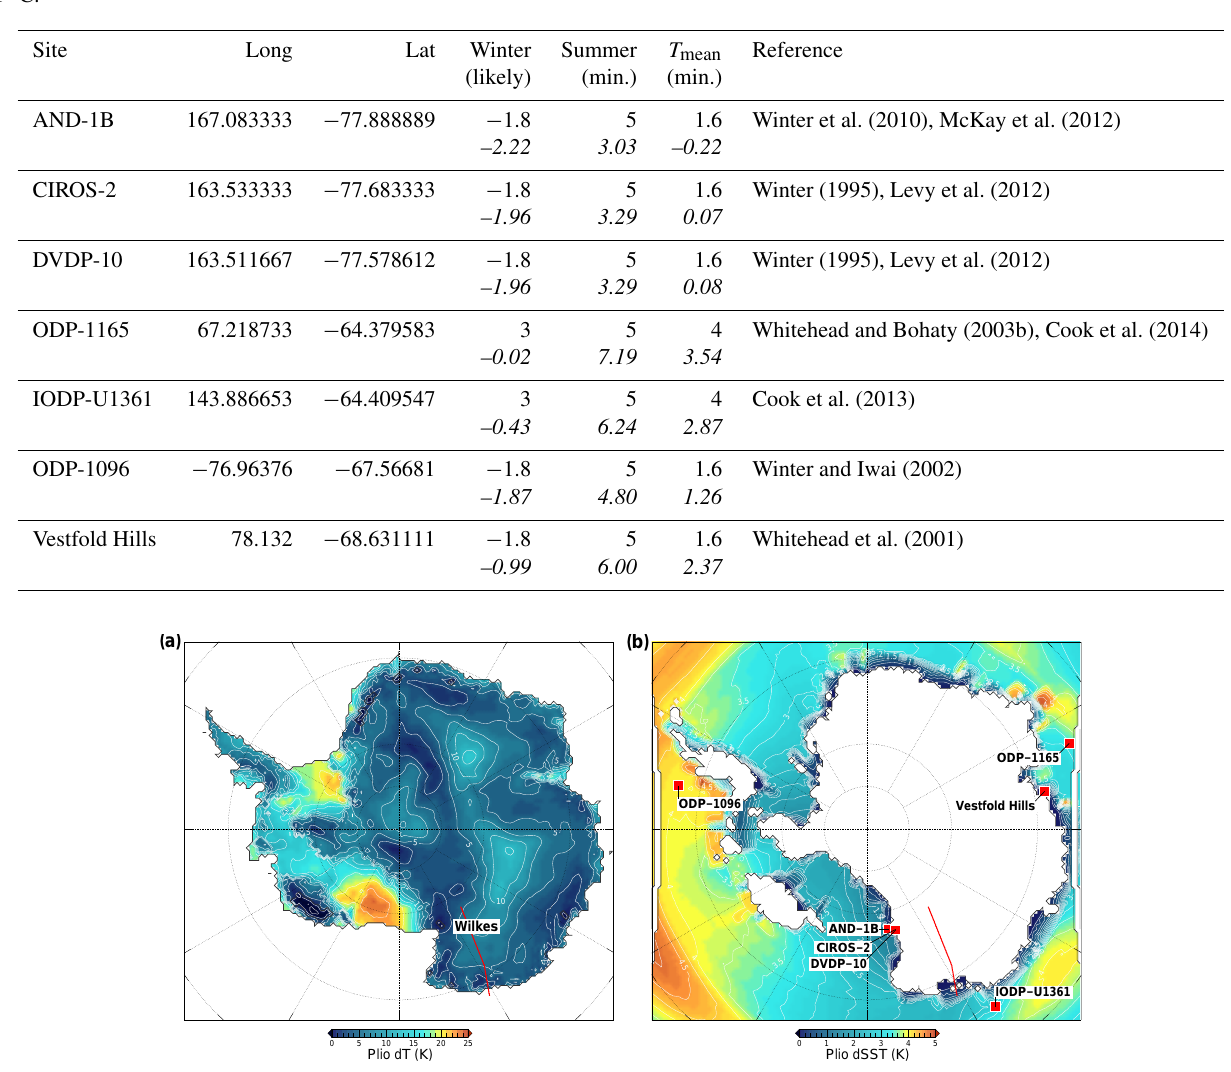
Table 1. Inferred high southern latitude winter, summer, and mean annual sea-surface temperatures from a range of proxy techniques compared to model predictions. Winter temperatures assume sea ice close to the coast but not in open water. Summer temperatures (and thus T mean also) are minima, and could be higher. Absolute sea-surface temperature predictions from the RCM shown for each site in italics. Although the considerable uncertainties associated with temperature inferences from palaeoecological proxies make precise comparisons impossible, the data generally indicate an underestimate of mean annual sea-surface temperatures in the RCM that averages approximately 1 ◦ C.